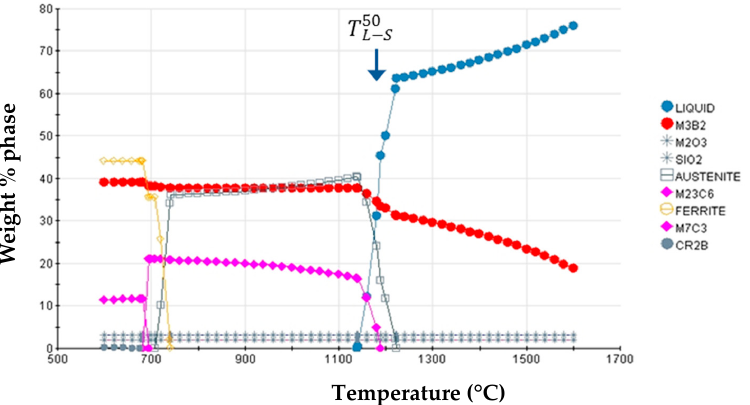
Figure 1. Particle size distribution of the starting powder (cumulative, left scale; integral, right scale).